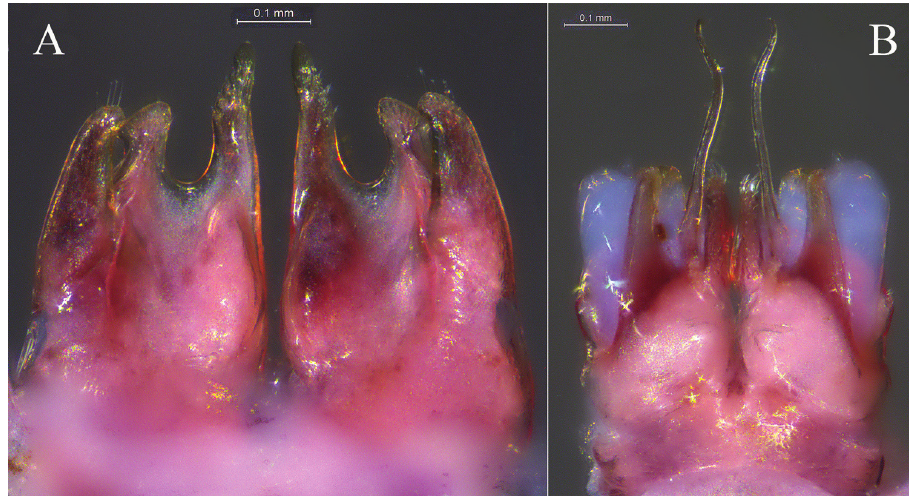
Figure 14. Glyphiulus guangnanensis sp. n., holotype. A anterior gonopods, caudal view B posterior gonopods, caudal view.